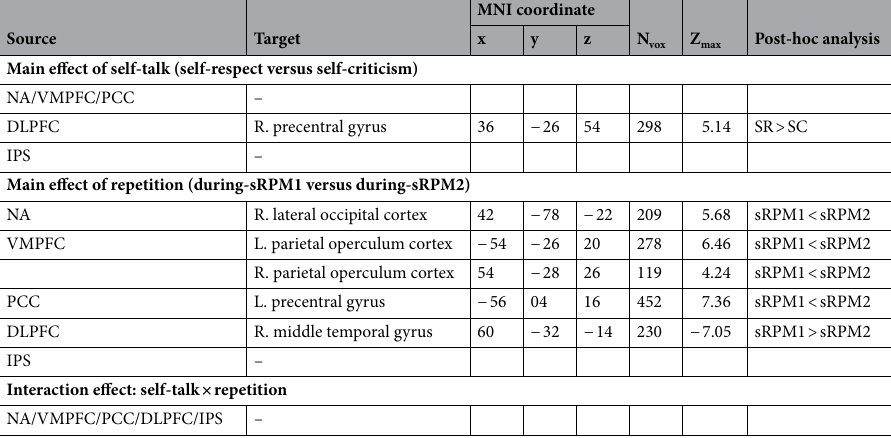
Table 2. Results of the seed-based functional connectivity analysis for brain states while performing the short form of Raven’s Progressive Matrices (sRPM) in the two different self-talk groups: self-respect and self-criticism. MNI Montreal neurological institute, N vox numbers of voxels, Z max maximum z-value within the cluster, L. left, R. right, NA nucleus accumbens, VMPFC ventromedial prefrontal cortex, PCC posterior cingulate cortex, DLPFC dorsolateral prefrontal cortex, IPS Intraparietal